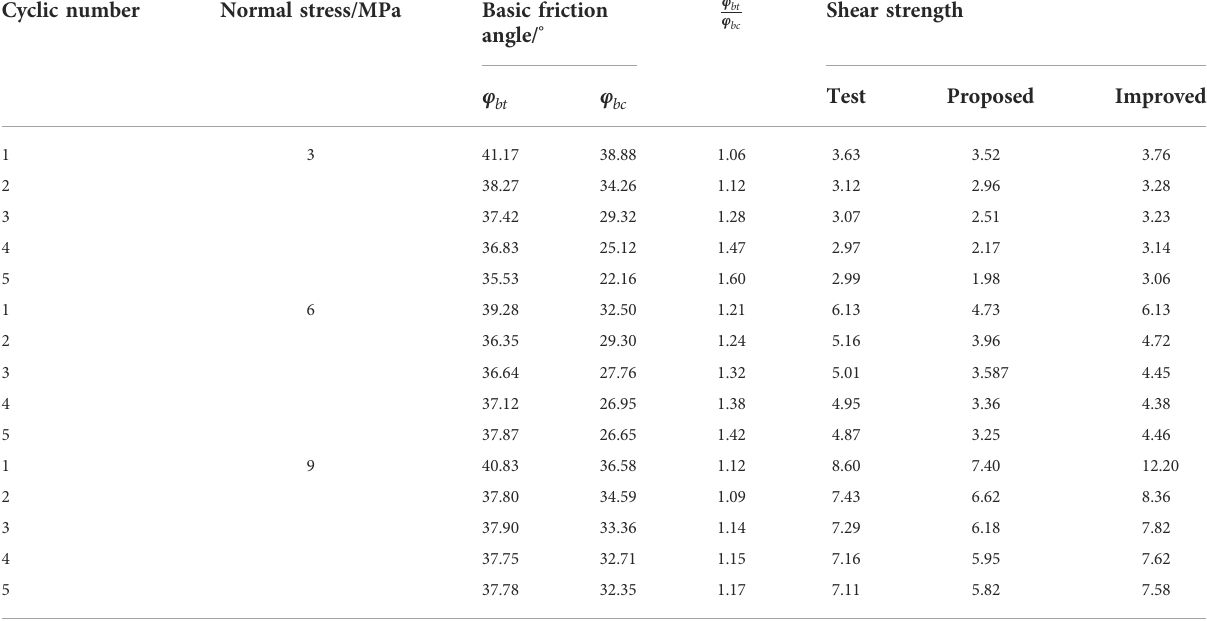
TABLE 2 Calculation parameters and obtained shear strengths. Cyclic